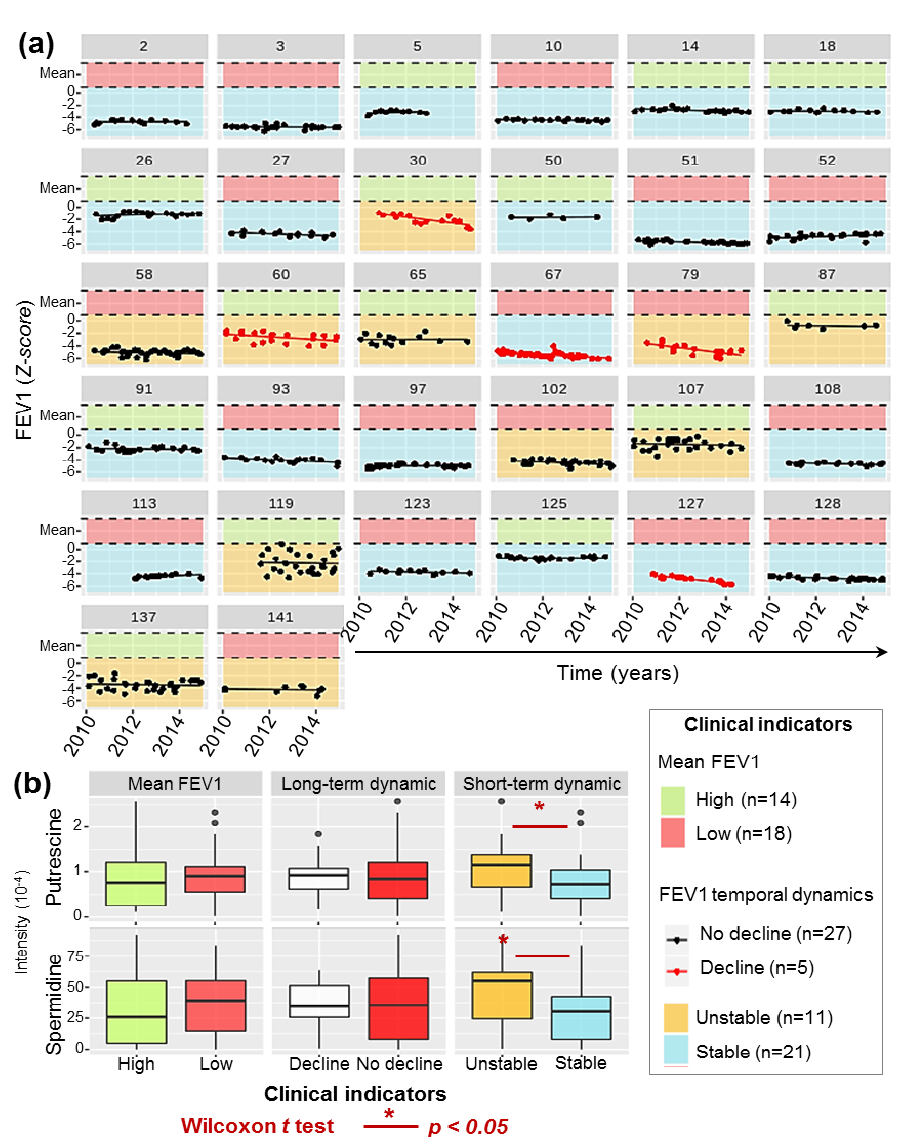
Figure 4. Relations between patients’ respiratory functions and the production of polyamines by P.a isolates. ( a ) Temporal series of all FEV1 measurements realized on the 32 patients of the cohort during the follow-up period and construction of clinical indicators. Average FEV1 for each patient was defined as high (green background) or low (red background), by comparison to the cohort average. FEV1 temporal dynamics was modeled using linear regression of the FEV1 measurements overtime as follows: (i) long-term dynamic was classified as in decline (red lines) if the slope was significantly under 0, not declining (black lines) if not; (ii) short-term dynamics were defined as unstable (yellow background) if the standard deviation of the residuals was above 40% or stable (blue background) if not. ( b ) Boxplots showing the putrescine and spermidine production (LC-HRMS peak intensity) by P.a per FEV1 based respiratory categories. The data presented in this figure have been translated into a table to make it accessible to colorblind readers (Supplementary Table